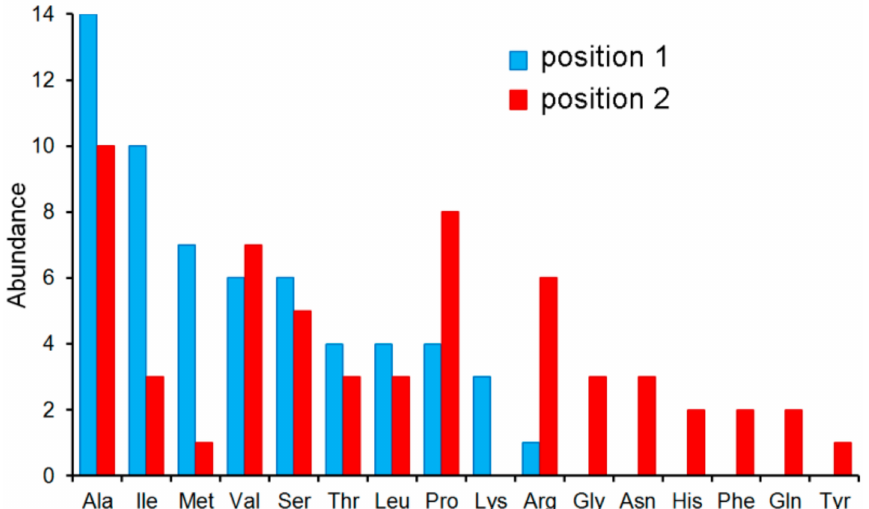
Figure 8. The ligand profile of PA4500. In total, 59 l -dipeptides caused T m shift of more than 3 ◦